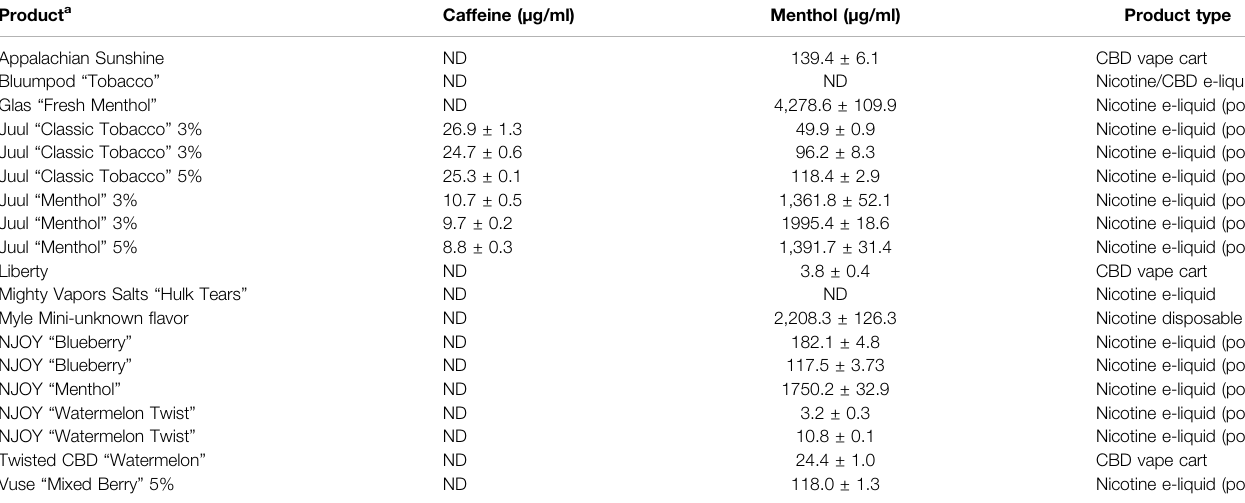
TABLE 3 | Caffeine and menthol concentrations in e-liquids. Product a